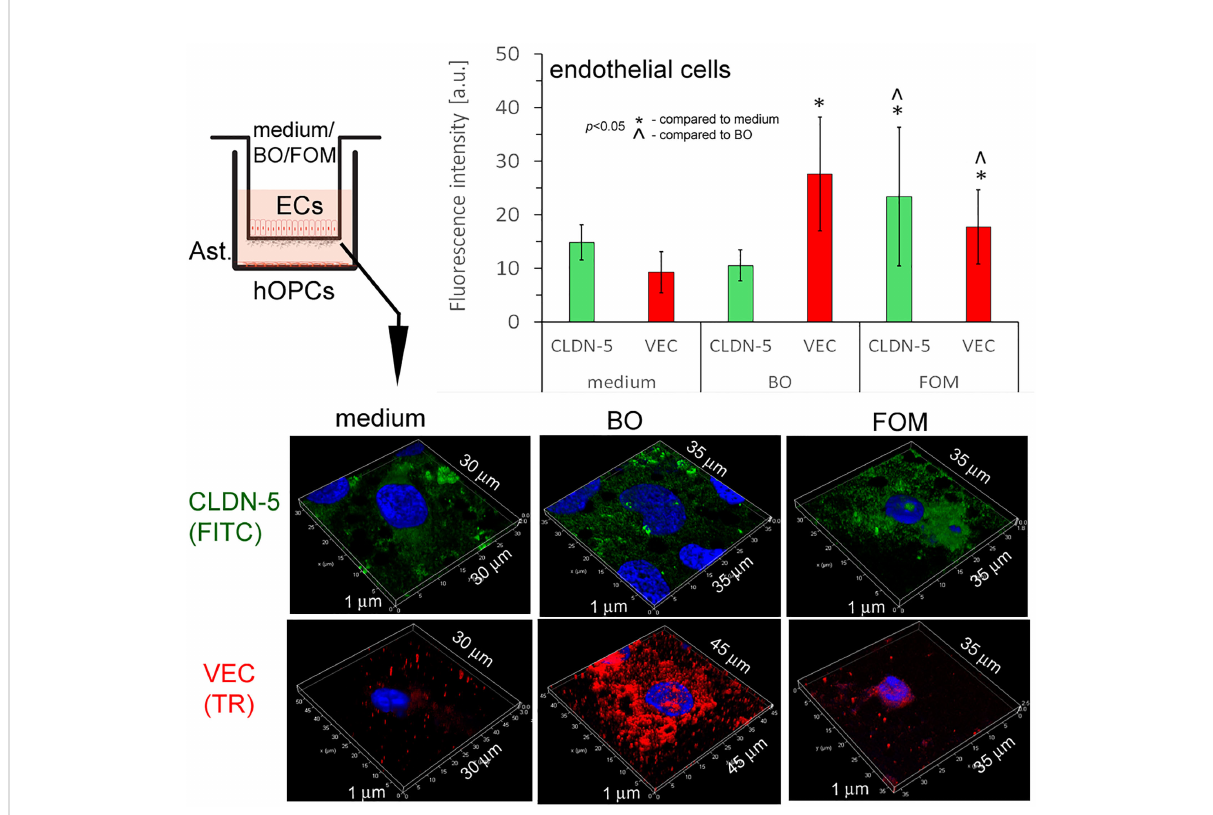
( Figure 7 ; Supplementary Table S2 ), despite that there were no signi fi cant differences in the percentage of TG (94.7%